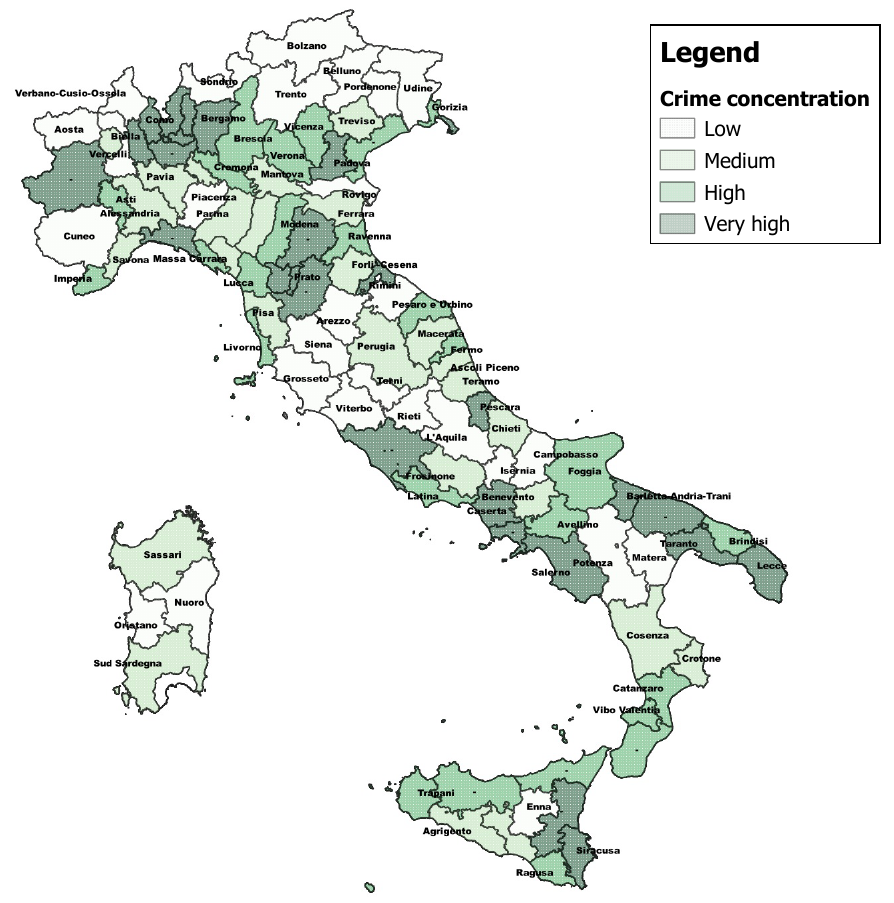
Figure 2. Concentration of the organised crime variable. Source: Authors processing of AIDA Bureau Van Dijk and Prefectures